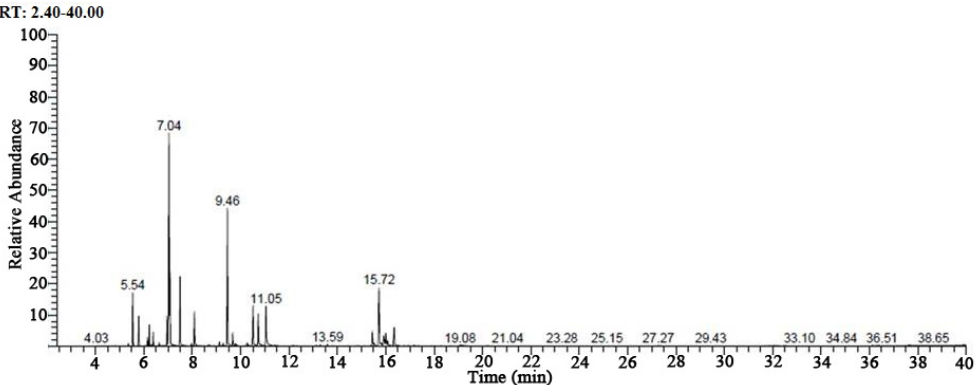
Figure 1. The GC/MS chromatogram of the analysis of Juniperus phoenicea leaf extract. Table 1. GC/MS analysis of Juniperus phoenicea leaf extract. Peak